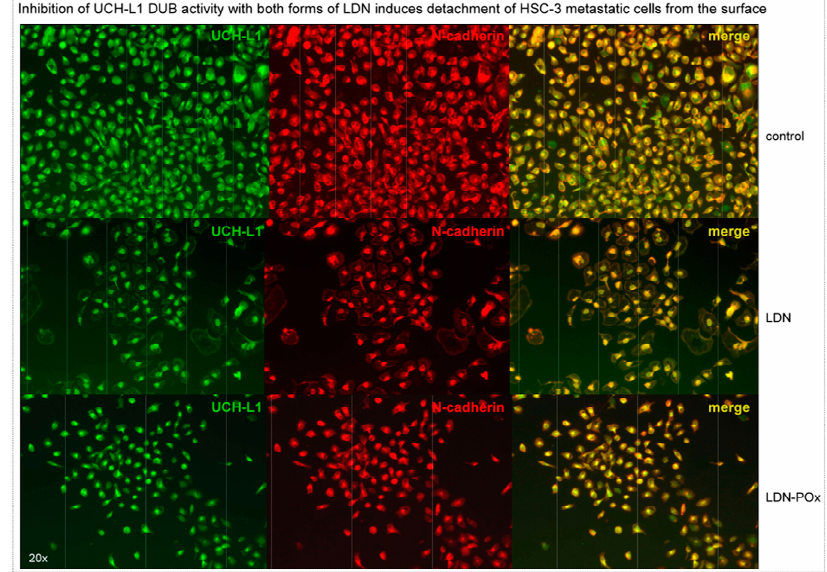
Figure 5. Inhibition of UCH-L1 DUB activity with LDN or LDN-POx induces detachment of metastatic carcinoma cells from the surface. Equal amounts of HSC-3 cells were plated at ~70–80% confluence and treated with free LDN and LDN-POx micellated forms of UCH-L1 inhibitor (3 μ M each, DMSO as control). For 24 h the cells were washed with phosphate-buffered saline (PBS), fixed in 4% Paraformaldehyde (PFA) and fluorescent immunostaining was performed with UCH-L1 and N-cadherin (as a marker of metastatic carcinoma cells) antibodies. Scale bar: 200 μ m.